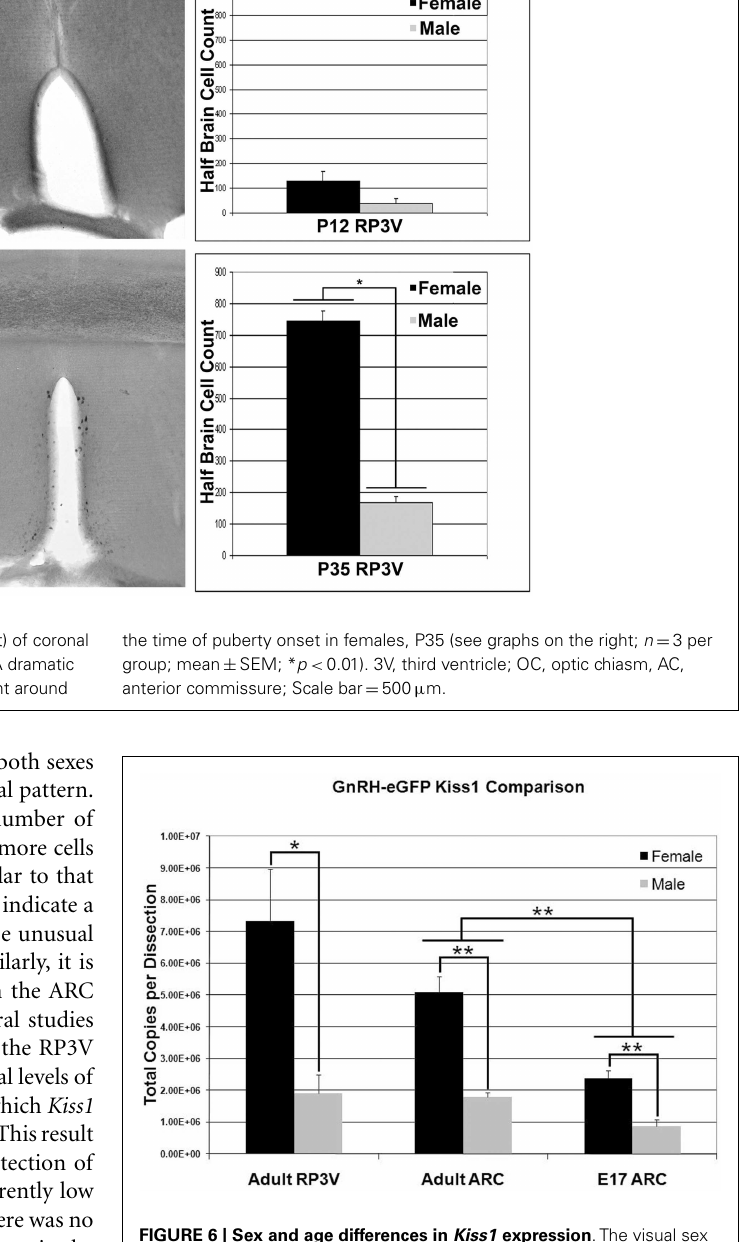
FIGURE 6 | Sex and age differences in Kiss1 expression .The visual sex difference in the amount of Kiss1 detected by ISH in hypothalamic tissue was confirmed by QPCR.There was a significant difference in total copy number between males and females at both ages in the ARC and in the RP3V of adults. In addition, a post hoc analysis showed a significant difference in the amount of Kiss1 between adults and embryos in the ARC ( n = 3 for each group; data is mean ± SEM; * p < 0.05, ** p < 0.01).